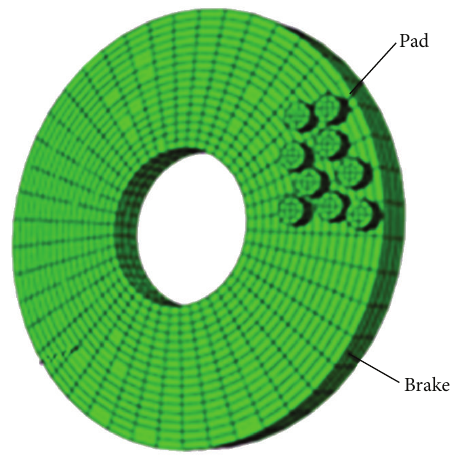
Figure 3: Brake pad and brake disc finite element